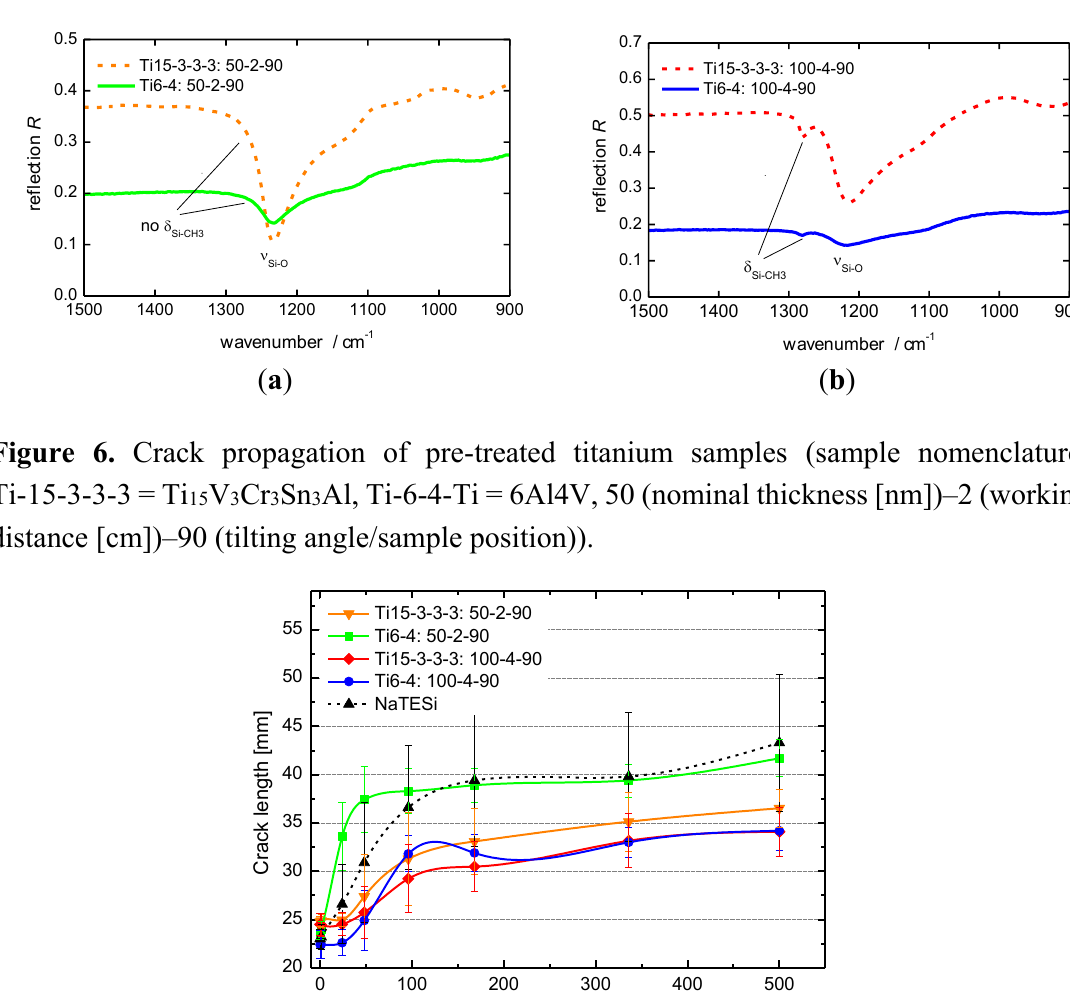
Figure 5. FTIR spectra of deposited film on titanium alloy ( a ) 50 nm nominal oxide layer thickness and at 2 cm working distance; ( b ) 100 nm nominal oxide layer and at 4 cm working distance.